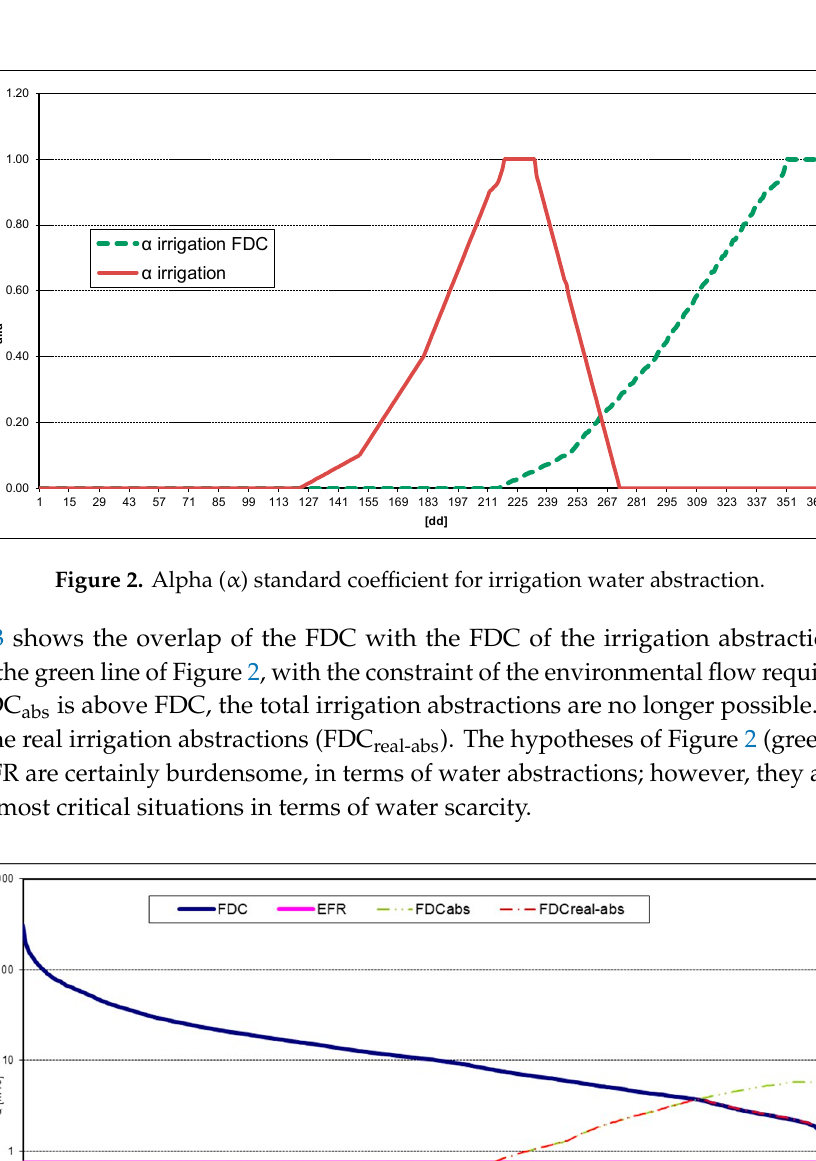
Figure 3. Flow Duration Curve (FDC), environmental flow requirement (EFR), FDC of irrigation abstractions (FDC abs ) and FDC of real irrigation abstractions (FDC real-abs ).